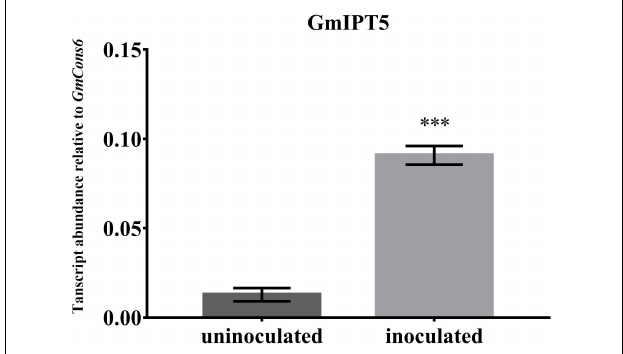
FIGURE 5 | Expression of GmIPT5 in the GmNARK mutant shoot following inoculation with B. diazoefficiens . Three-week old trifoliate leaves were harvested after plants were either inoculated with B. diazoefficiens or uninoculated. Expression levels are relative to the housekeeping gene GmCons6 . Bars represent mean ± SEM of two biological replicates ( n = 5 plants per replicate). Asterisk shows significant differences in expression (Student’s t -test, ∗∗∗ P ≤